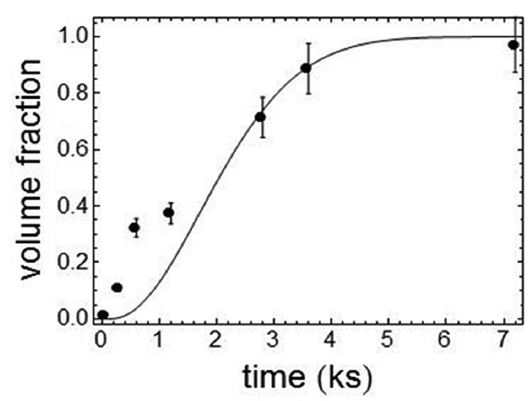
Figure 6. Comparison between total volume fraction transformed obtained by computer simulation (solid line) and experimental data from Magnusson et al. 2 (filled